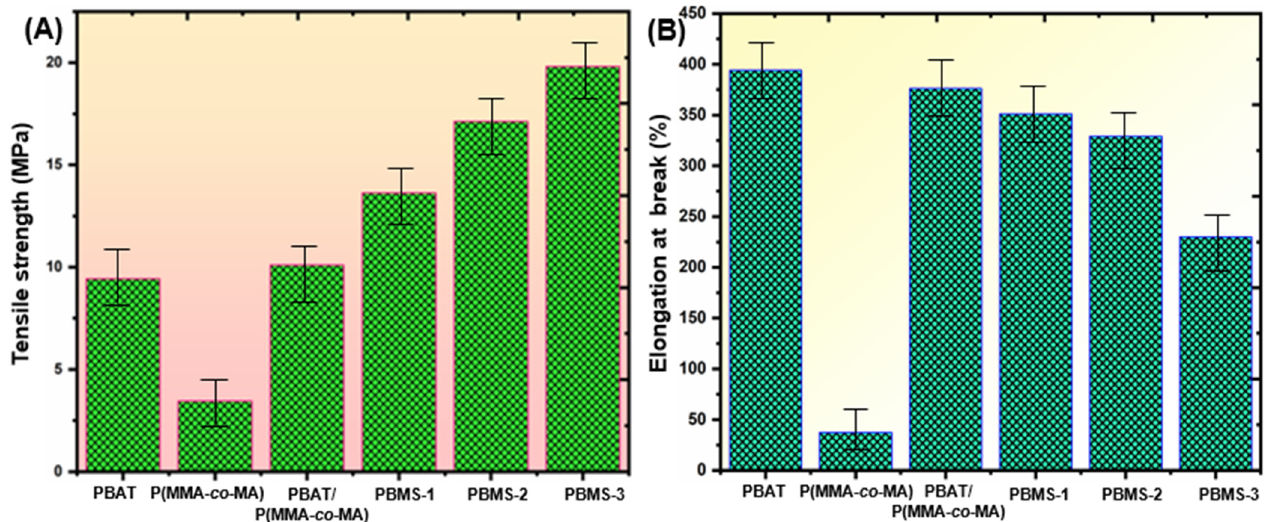
Figure 9. Mechanical characterizations of PBAT/P(MMA- co -MA)–SiO 2 composites: ( A ) tensile strength (MPa) and ( B ) elongation at break (%). Error bars represent ±5.01 standard errors. The tensile and EB of neat PBAT matrix (9.43 MPa and 394.2%, respectively) and